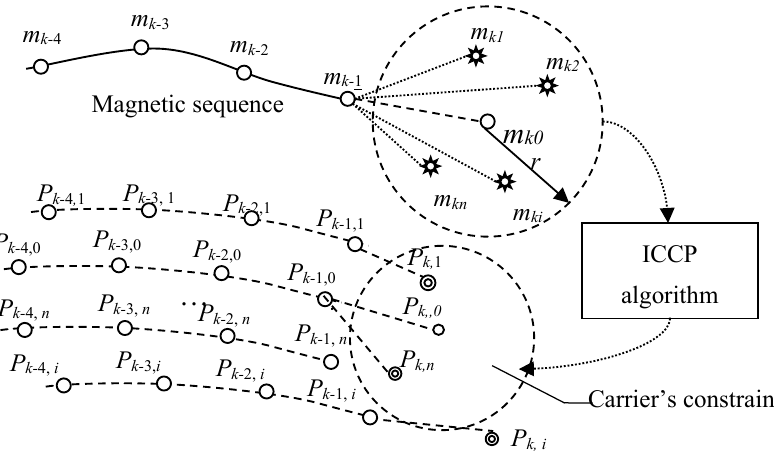
Figure 2. Basic idea of PDA-ICCP algorithm.